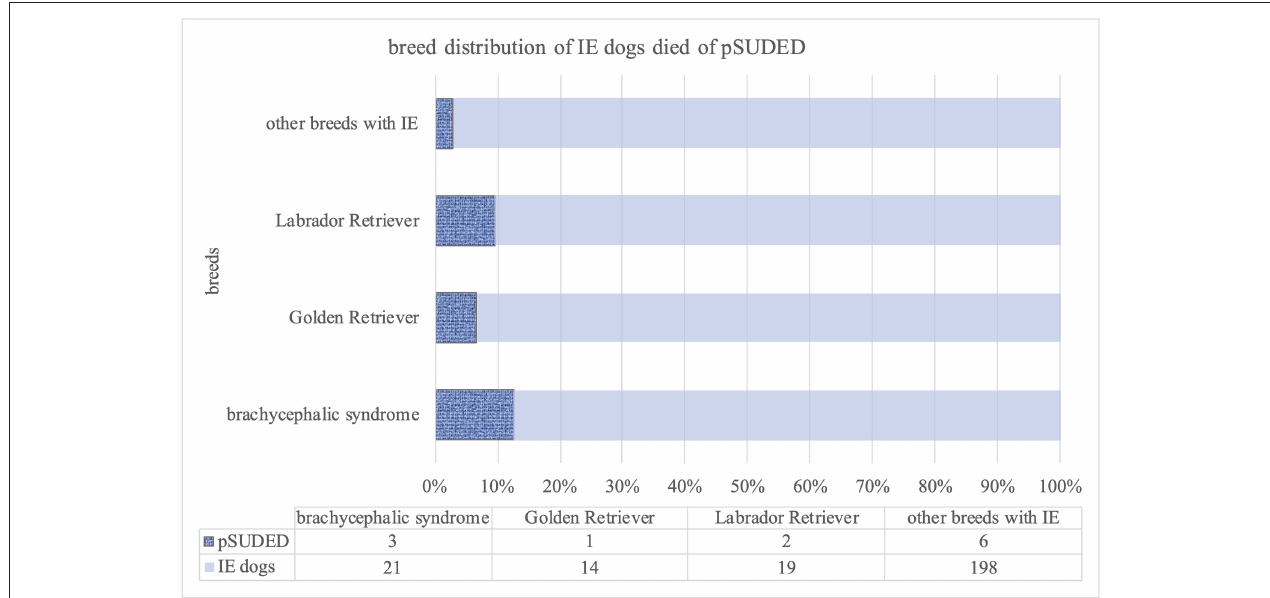
FIGURE 2 | Graphical representation of included dogs with